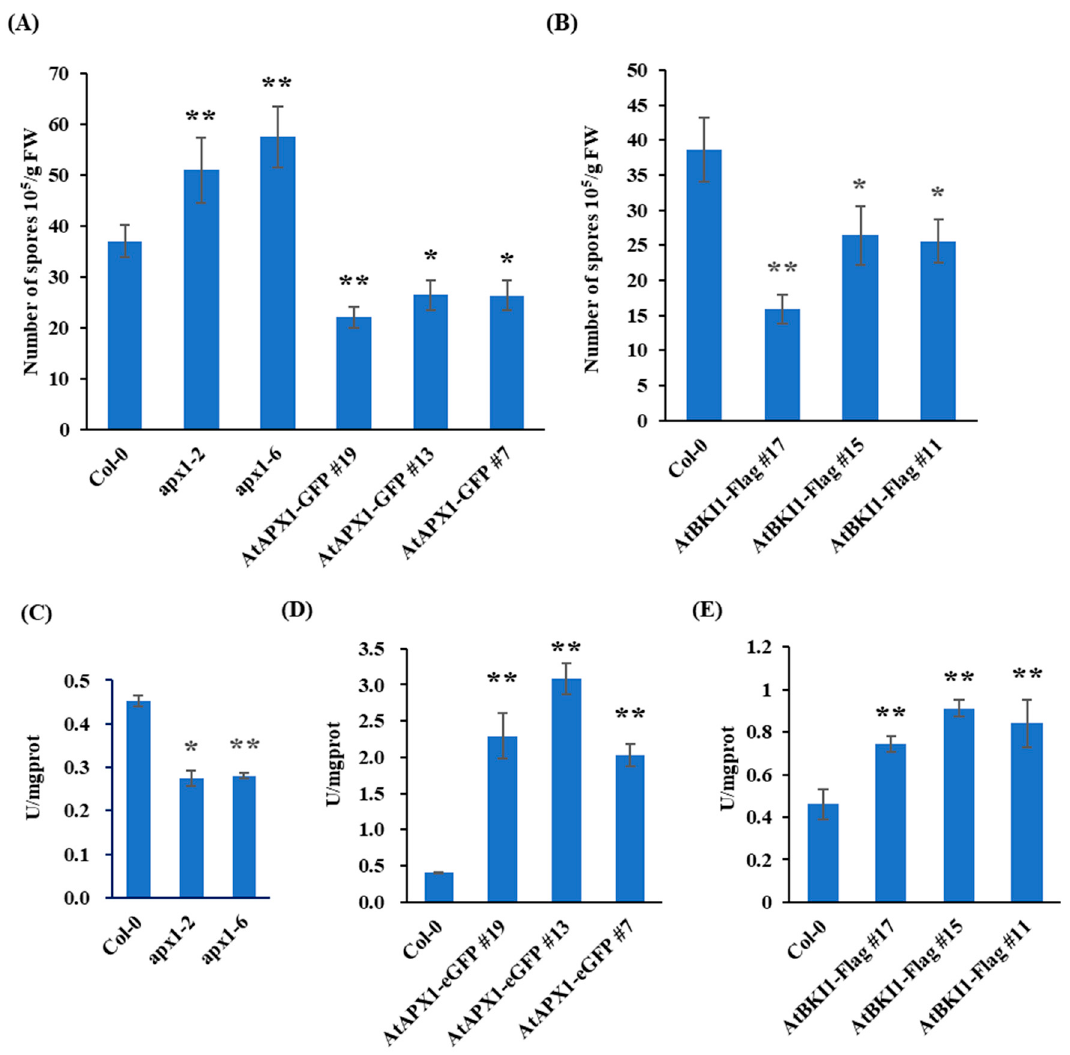
Figure 6. Function of AtBKI1 and AtAPX1 in Arabidopsis in resistance and APX activity. ( A ) Two- week-old AtBKI1 overexpression lines were inoculated with H. arabidopsidis . Spores were counted at 4 dpi. Data are means ± SD from 3 biological replicates. ( B ) Two-week-old AtAPX1 overexpres- sion lines were inoculated with H. arabidopsidis . Spores were counted at 4 dpi. Data are means ± SD from 4 biological replicates. ( C – E ) Total APX activity of apx1 mutants, Arabidopsis plants overex- pressing AtAPX1 and AtBKI1. Data are shown as means ± SD ( n = 3). * Represents significant differ- ence ( p < 0.05, Student’s t test). ** represents extremely significant difference ( p < 0.01, Student’s t test).